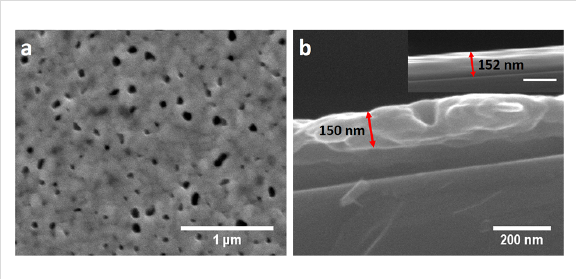
Figure 5: (a) SEM image of 200 nm sputtered silver film treated with argon plasma (g16.7-p200) for 30 min. (b) Cross-sectional SEM image of 200 nm sputtered silver film treated with argon plasma (g16.7-p200) for 30 min showing the actual thickness after argon plasma treatment compared to the as-sputtered silver film shown in the inset (scale bar: 200 nm). Figure 6: SEM images of a 200 nm sputtered silver film treated with